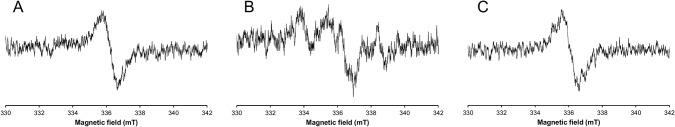
Radiation-induced signal recorded in irradiated experimental resins at 100 Gy.Bis-GMA 100% (A), UDMA 100% (B), G/T 0.3582/0.6418 (C).